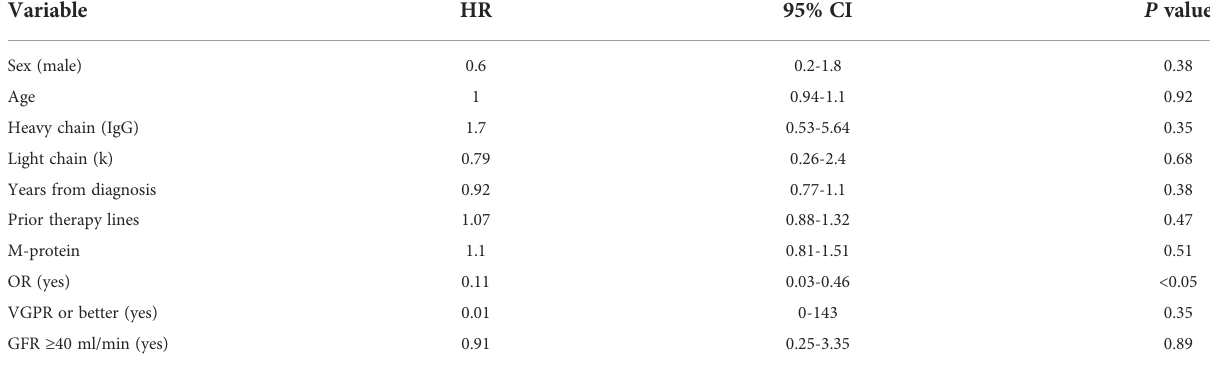
TABLE 3 Univariate analysis — progression-free survival (PFS).